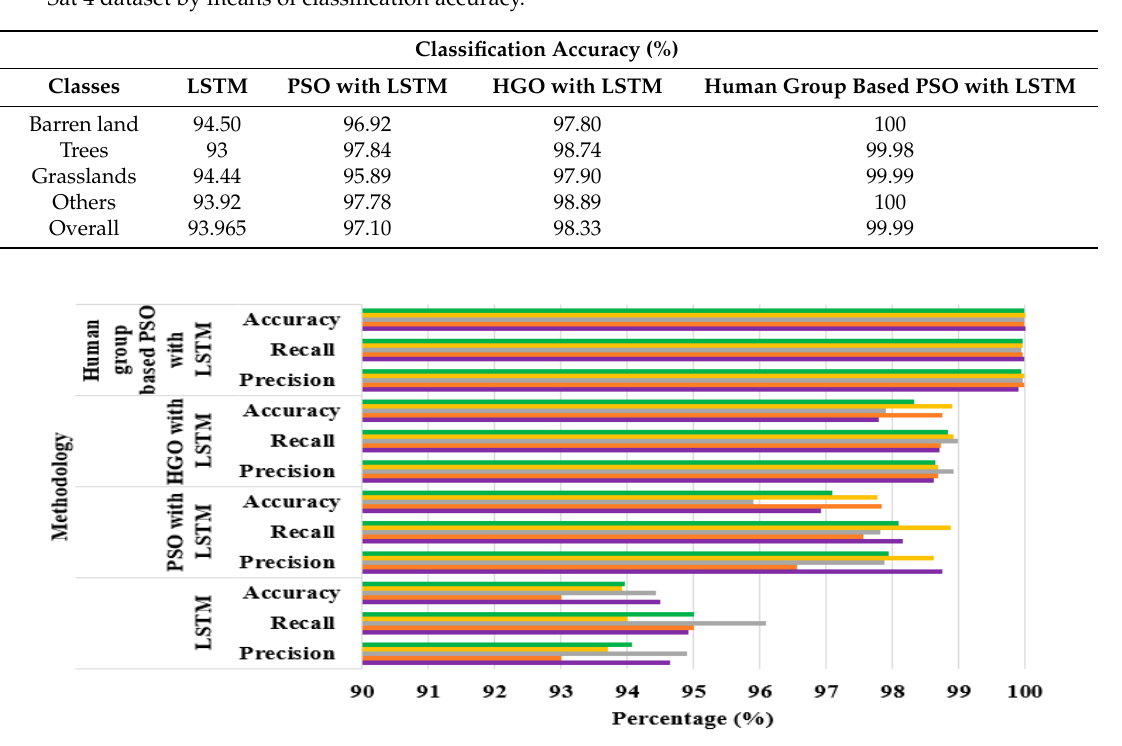
Table 8. Comparative analysis of different neural networks with PSO and HGO.